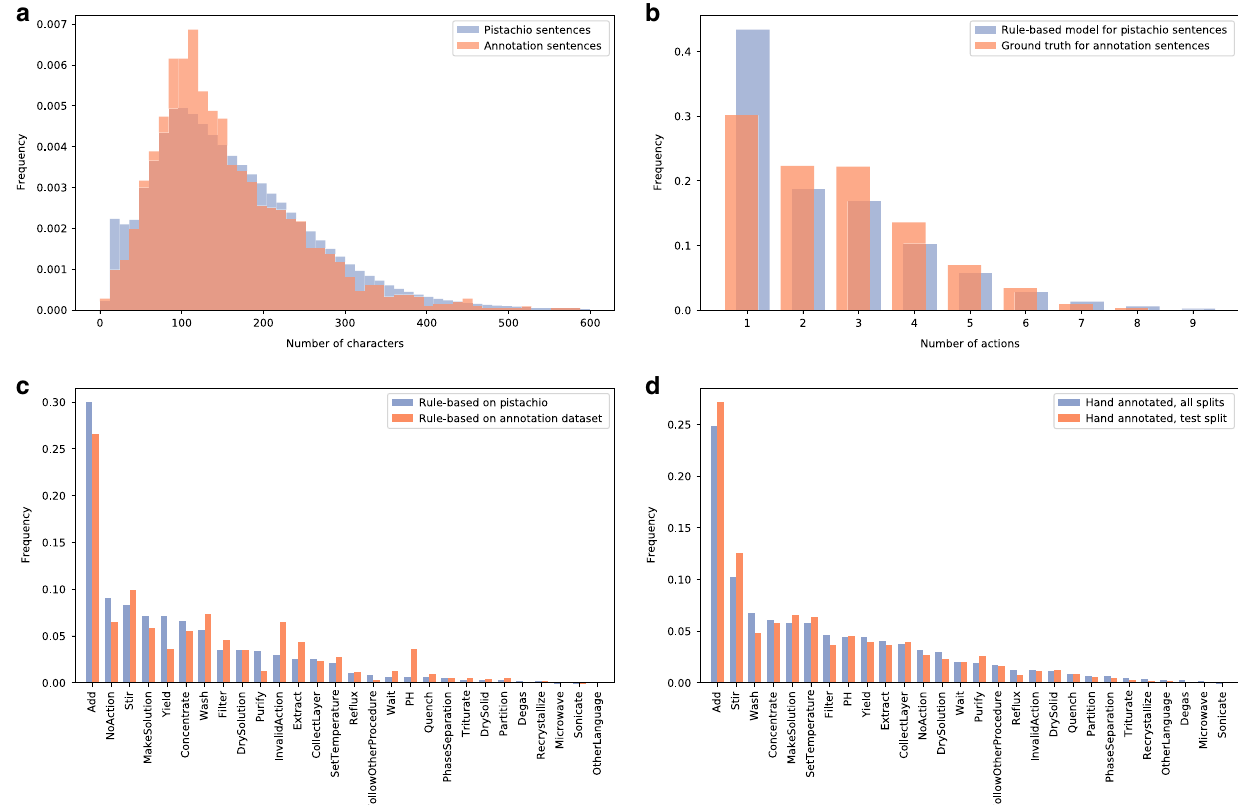
Fig. 2 Statistics of the Pistachio and annotation datasets. a Distribution of the number of characters for sentences from Pistachio and from the annotation dataset. b Distribution of the number of actions per sentence. For the Pistachio dataset, this number is computed from the actions extracted by the rule- based model. For sentences from the annotation dataset, this number is determined from the ground truth (hand annotations). c Distribution of action types extracted by the rule-based model on the Pistachio dataset and on the annotated dataset. The action types are ordered by decreasing frequency for the Pistachio dataset. d Distribution of action types determined from hand annotations for the full annotation dataset and its test split. The action types are ordered by decreasing frequency for the full annotation dataset.